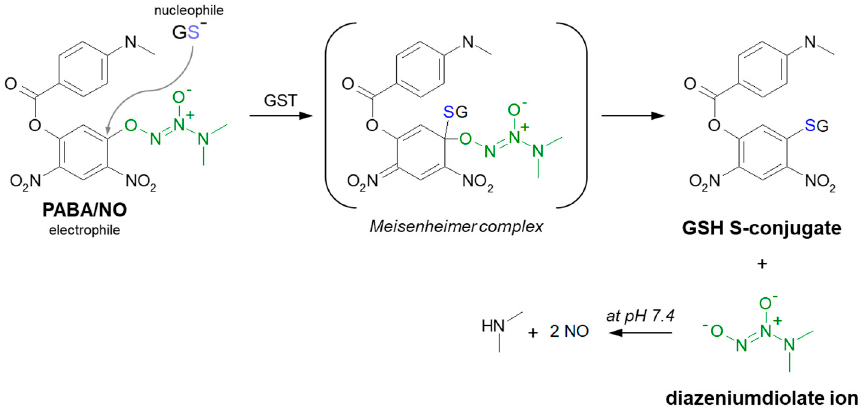
Figure 10. Scheme of the GST-catalyzed reaction of GSH with PABA/NO showing the formation of the Meisenheimer complex as the reaction intermediate [107]. A leaving group in PABA/NO molecule is marked in green.